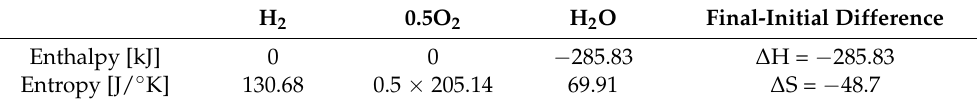
Table 3. Transformations in the fuel cell.